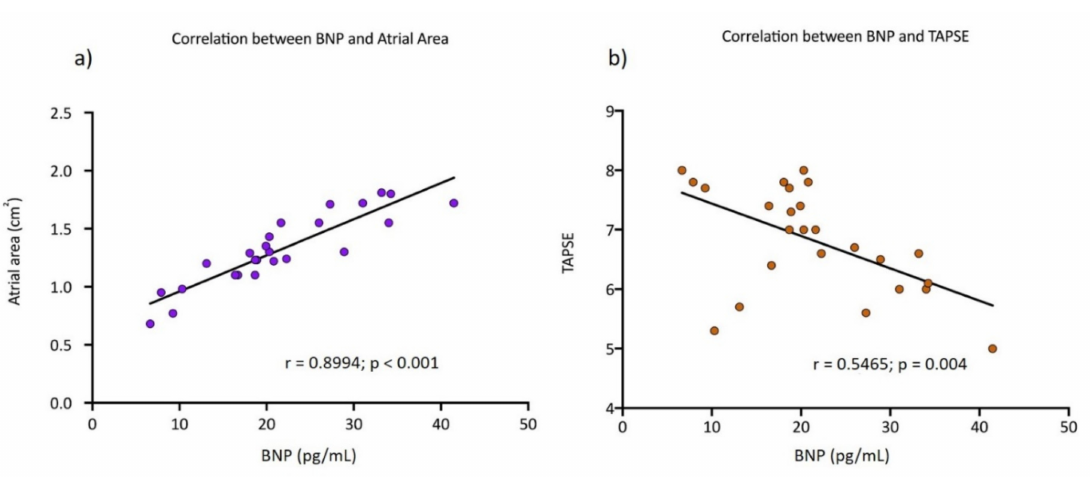
Figure 4. ( a ) Scatter plot exhibits the positive linear correlation between the atrial area (cm 2 ) and the BNP plasma levels (pg / mL) (r = 0.8994, p < 0.001). ( b ) Scatter plot shows the negative correlation between the tricuspid annular plane systolic excursion (TAPSE, mm) and the BNP plasma levels (pg / mL) (r = 0.5465, p =